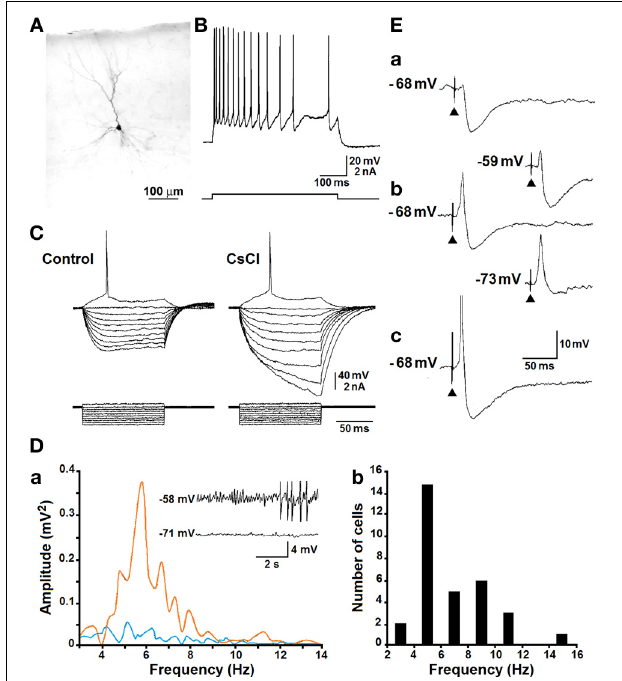
FIGURE 2 | (A) Photomicrograph of a neurobiotin-filled perirhinal cortex cell that corresponds to an upright pyramidal neuron (cf., Furtak et al., 2007). Scale bar, 100 μ m. (B) Regular repetitive firing with adaptation is generated by a pyramidal-like neuron recorded in the perirhinal cortex during injection of a pulse of depolarizing current. (C) Effects induced by bath application of CsCl (3mM) on the voltage responses to intracellular current pulses; note that under control conditions stepwise hyperpolarization of the membrane leads to the appearance of a sag toward the resting level as well as that addition of CsCl to the bath increases the neuronal input resistance and abolishes the sag. Bottom traces represent current monitor. (D) Power spectra of the intracellular signals recorded in the cell shown in the insets at two different levels of depolarization are illustrated in (a) ; note that the spectrum obtained from the signal recorded at − 58mV (orange line) is characterized by a peak at ∼ 5 . 5Hz. In (b) , histogram of the peak frequencies of membrane oscillations recorded in 29 perirhinal cortical neurons. (E) Responses recorded intracellularly from a perirhinal cortex neuron following local single-shock extracellular stimuli of progressively increasing strength (from a to c ). Inserts in panel (b) illustrate the intracellular responses recorded during injection of depolarizing ( − 59mV trace) or hyperpolarizing ( − 73mV trace)